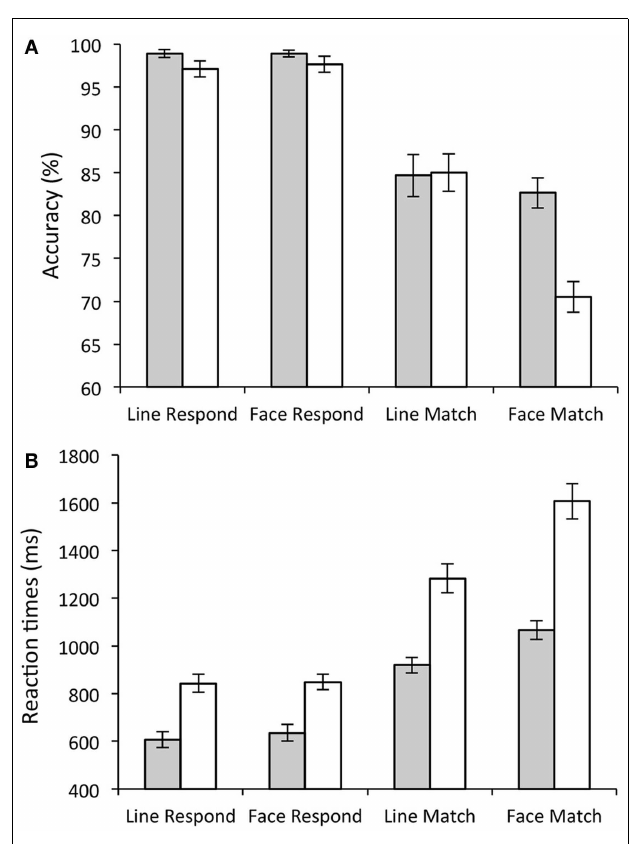
FIGURE 2 | Behavioral Results . Bar graphs showing task accuracy (A) and response times. (B) Gray bars show average scores for young participants; white bars show average scores for elderly participants. Error bars show the standard